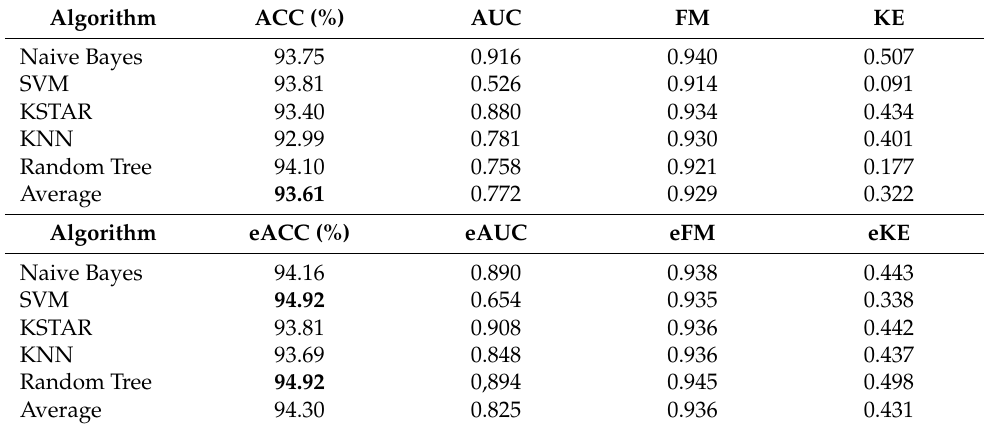
Table 7. Classification results for SFP XP-TDD data set.